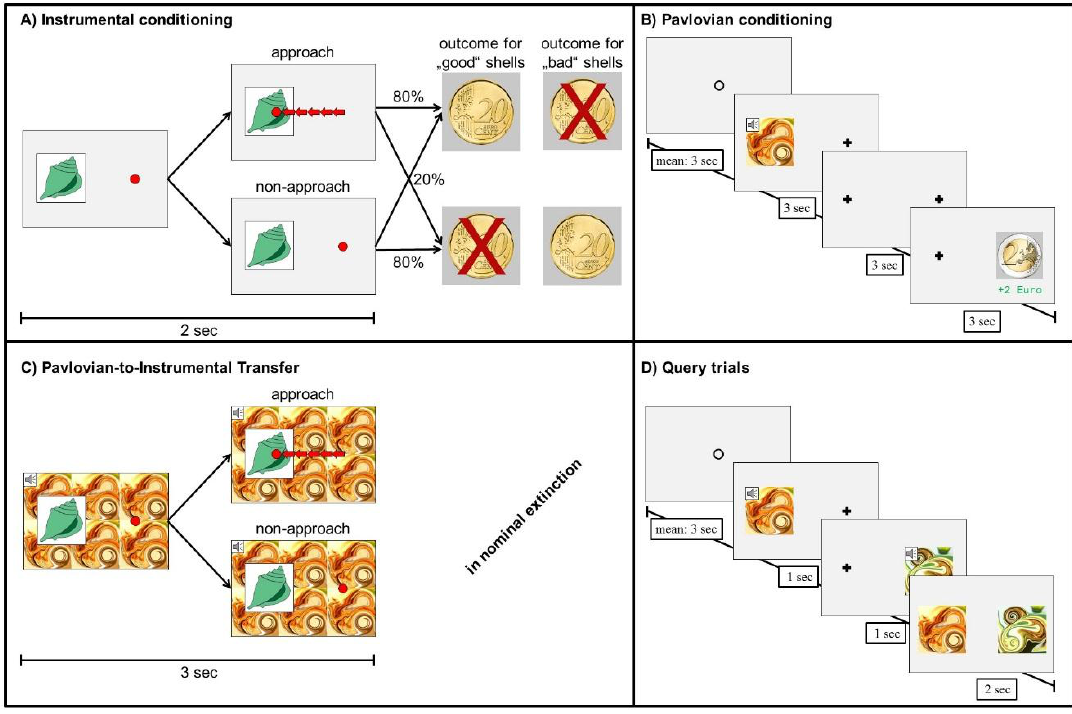
Figure 2. Pavlovian-to-instrumental Transfer (PIT) task. ( A ): Instrumental training: collecting a ’good’ shell was rewarded in 80% while not collecting a ‘good’ shell punished in 80%. The opposite reinforcement contingencies applied to ’bad’ shells. Red arrows indicate the five or more button presses required to approach and collect the presented shell. By trial and error, subjects learned to collect or not to collect three out of six shells. ( B ): Pavlovian conditioning: subjects passively viewed a conditioned stimulus (CS), which was deterministically followed by an unconditioned stimulus (US). As CS, a compound of a tone and five fractal-like visual stimulus was used. USs were pictures of a coin ( − 2 € , − 1 € , 0 € , + 1 € , + 2 € ). ( C ): Transfer: subjects were asked for the instrumental response, while the background was tiled with the CS. Trials with drink-related background stimuli are not displayed. ( D ): Query trials: Subjects were asked to choose the better (i.e., that was associated with the highest reward or lowest punishment during Pavlovian conditioning) between sequentially presented CSs.